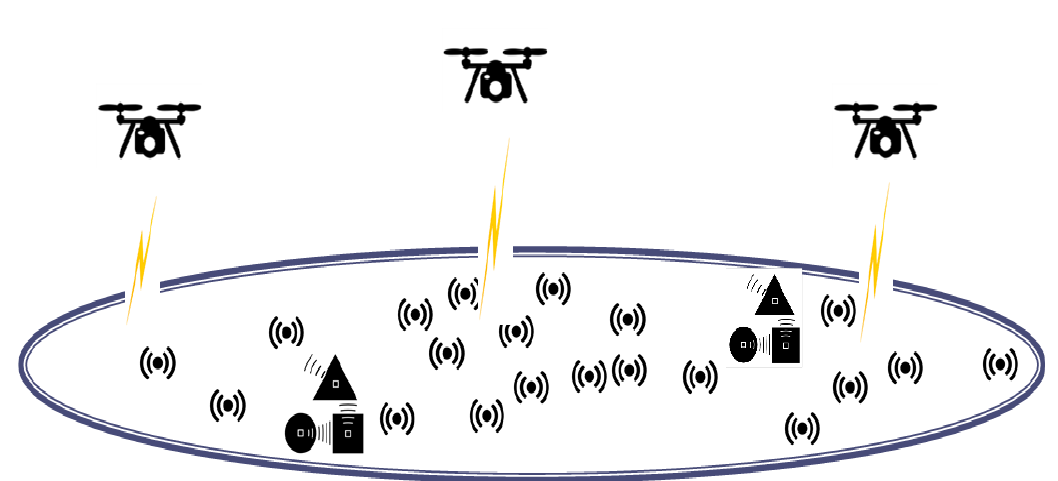
Figure 8. A scenario where multiple UAVs share the same